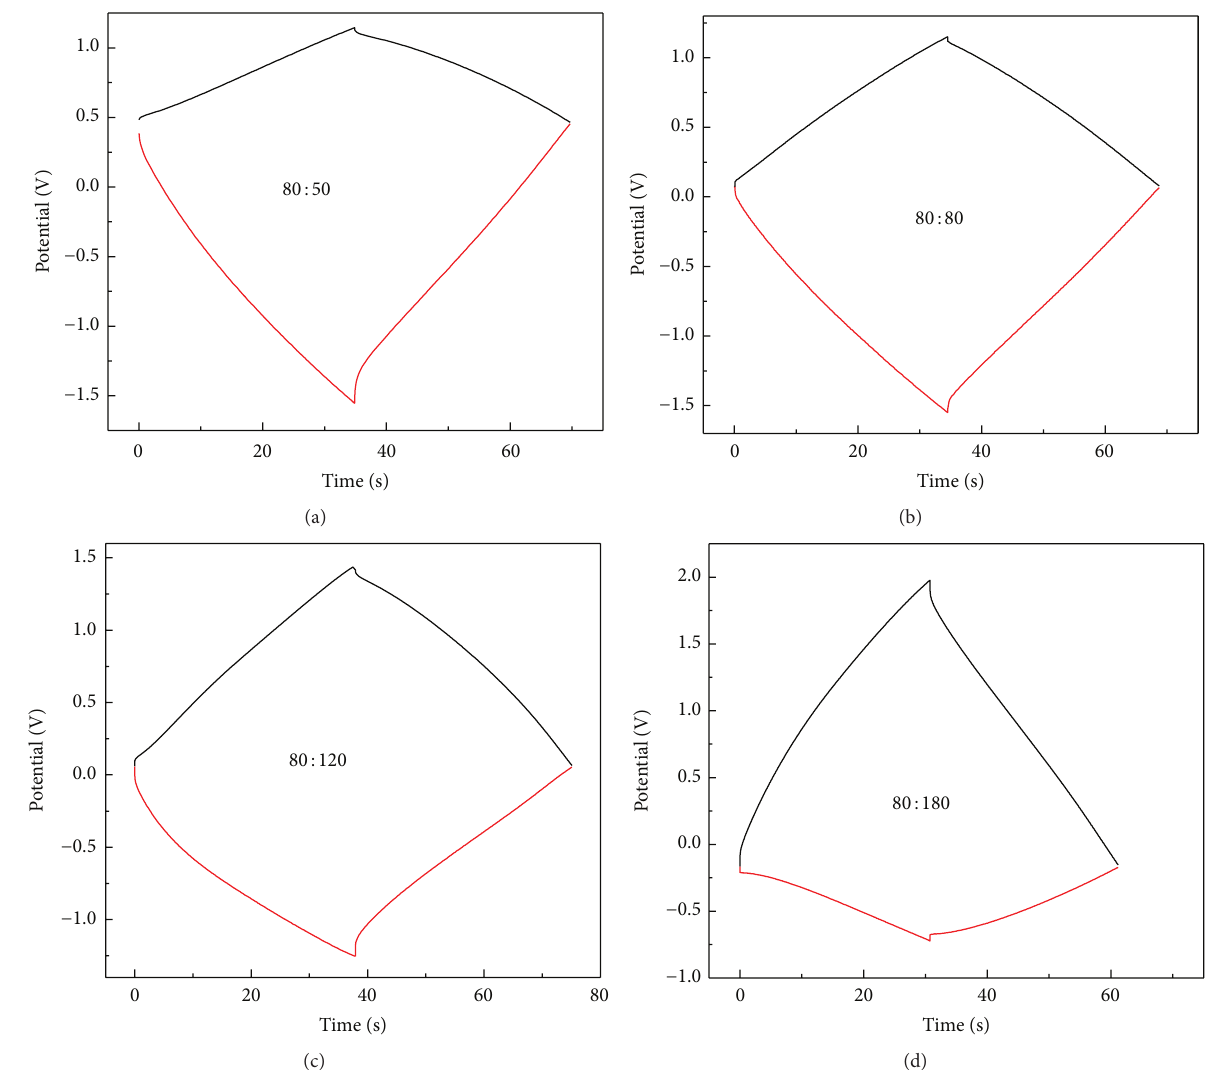
Figure 1: Galvanostatic charging-discharging cures. (a) 𝑟 = 80 :50. (b) 𝑟 = 80 : 80. (c) 𝑟 = 80 :120. (d) 𝑟 = 80 :180.